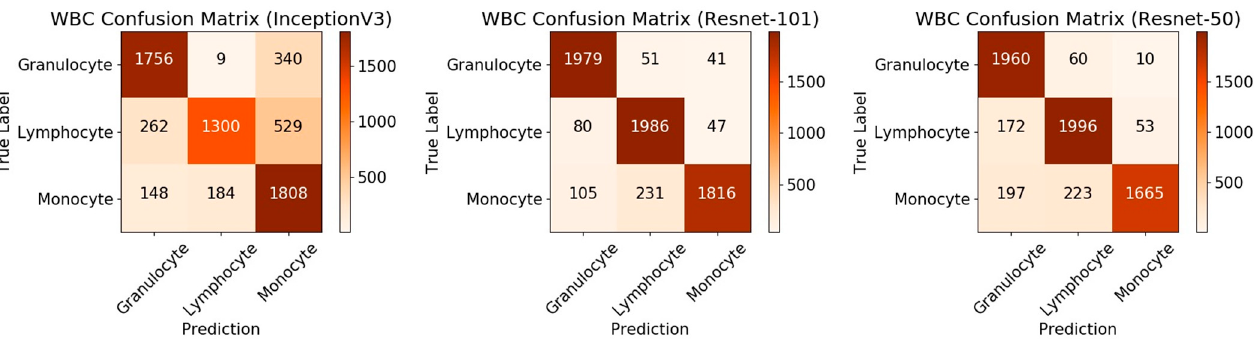
Table 3. Comparison of Confidence Intervals (CI) and Average Accuracy for different models.